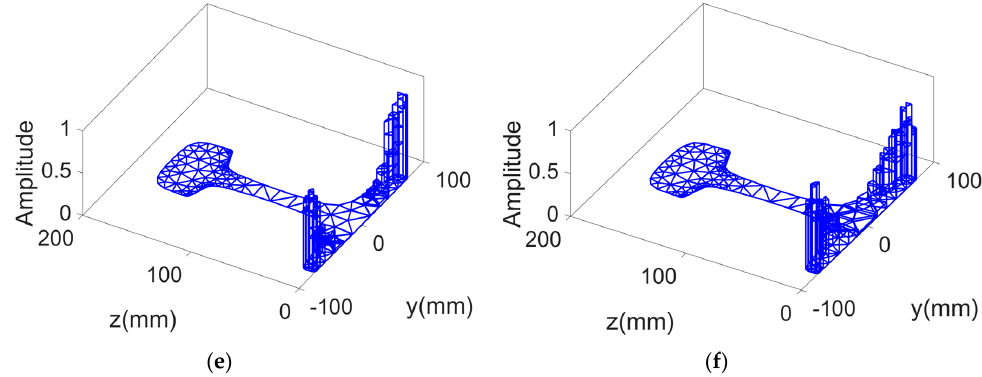
Figure 4. Normalized strain energy amplitude of modes. ( a ) mode 7; ( b ) mode 20; ( c ) mode 3; ( d ) mode 1; ( e ) mode 2; ( f ) mode 10.